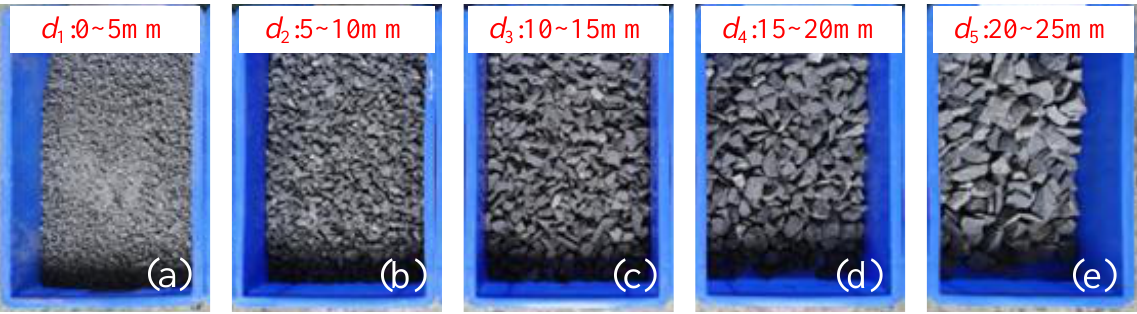
Figure 3. Preparation of samples with different kerogen particle sizes. ( a ) 0~5mm; ( b ) 0~5mm; ( c ) 5~10mm; ( d ) 10~15mm; ( e ) 20~25mm.